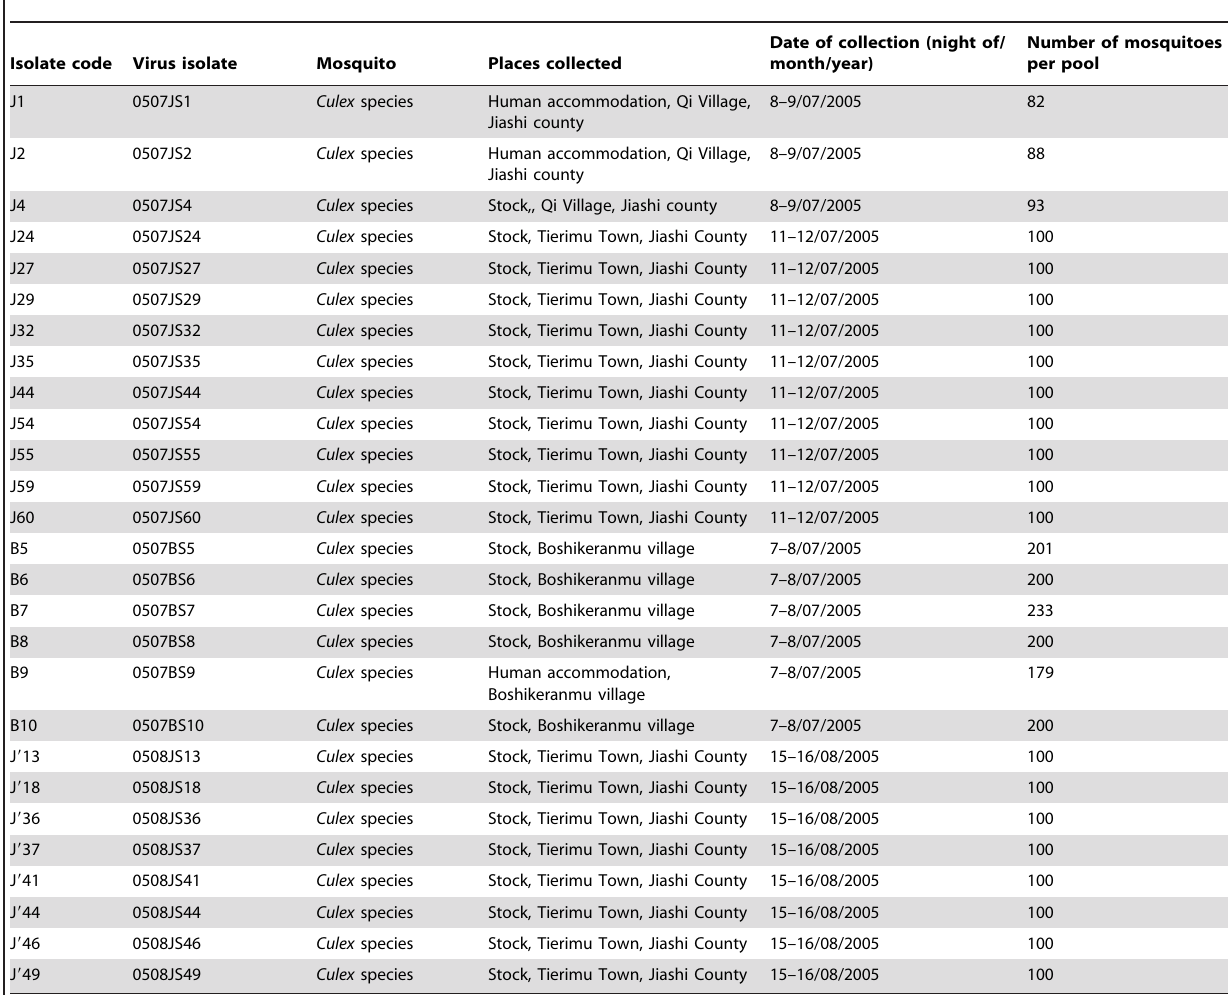
Table 1. LNV isolates made from wild-caught Culex mosquitoes collected between July and August 2005.